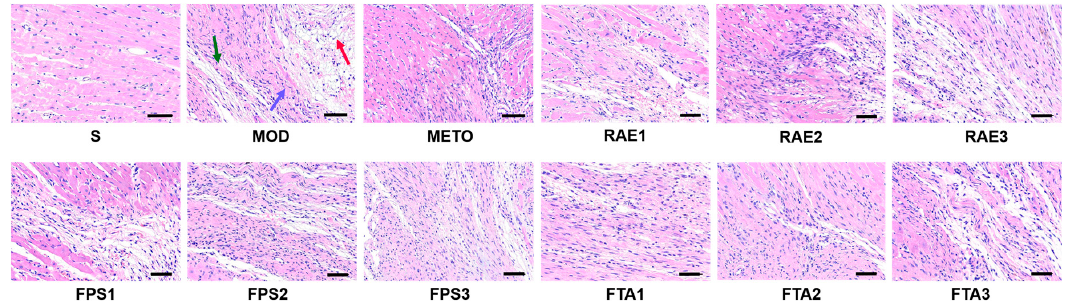
Figure 4. Photomicrographs of heart sections stained with hematoxylin–eosin in each group (close to the coronary vein), scale bar = 60 μ m. S, sham surgery group; MOD, MI model group; METO, metoprolol-treated group; RAE1/2/3, 1.6/0.8/0.4 g/kg, Radix Aconiti Lateralis Preparata extract groups; FPS1/2/3, 1.6/0.8/0.4 g/kg fuzi polysaccharides groups; FTA1/2/3, 1.6/0.8/0.4 g/kg fuzi total alkaloid groups. The green arrow indicates damaged myocardial fibers, the red arrow indicates vascular lesions, and the lilac arrow indicates inflammatory cell infiltration.